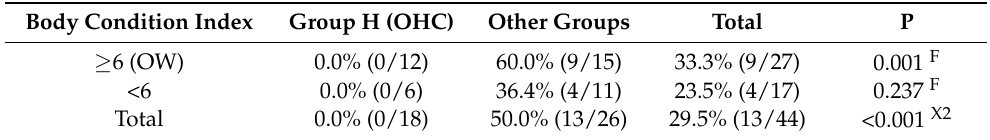
Table 5. Complication frequency in laparoscopic access between Group H (using optical helical cannula, OHC) versus the rest of the systems studied and the total of the study, comparing overweight (OW) horses with non-OW horses with a body condition score < 6. Body Condition Index Group H (OHC) Other Groups Total P ≥ 6 (OW) 0.0% (0/12) 60.0% (9/15) 33.3% (9/27) 0.001 F <6 0.0% (0/6) 36.4% (4/11) 23.5% (4/17) 0.237 F Total 0.0% (0/18) 50.0% (13/26) 29.5% (13/44) <0.001